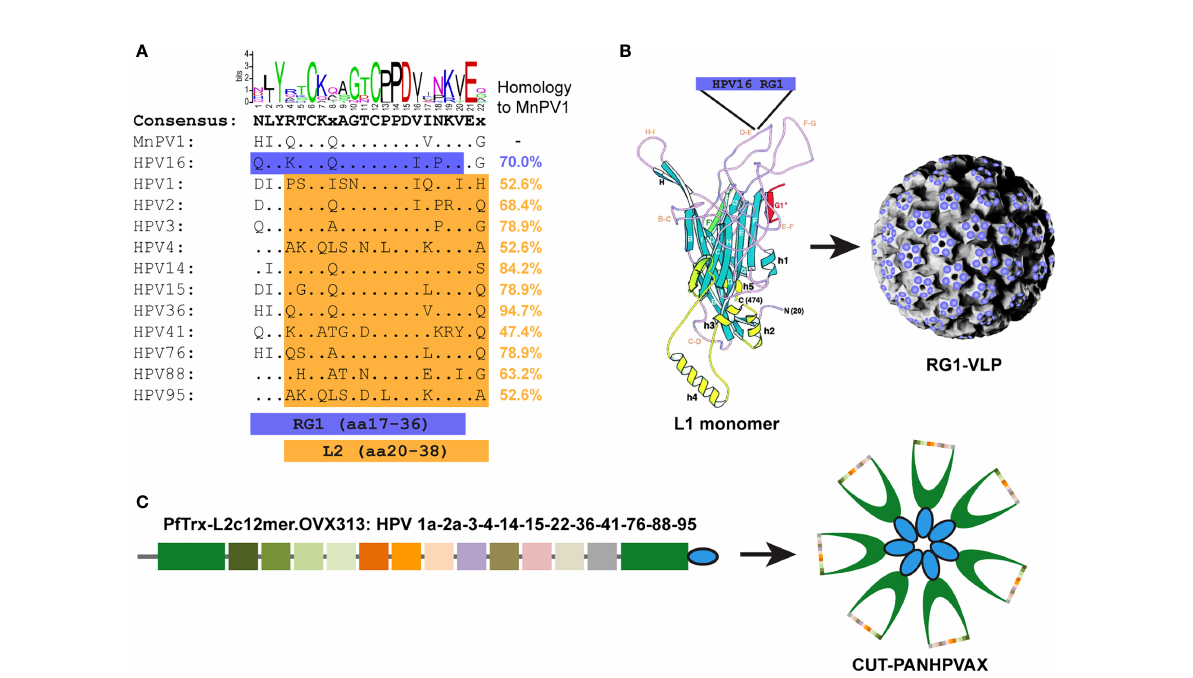
FIGURE 1 L2-based vaccines used in the study. (A) Alignment of L2 amino acid (aa) sequences of MnPV and HPV types either used in RG1-VLPs (HPV16 L2 aa17-36, referred to as ‘ RG1 ’ epitope, blue) or CUT-PANHPVAX (L2 aa20-38, orange of indicated HPV types) vaccine. Sequence identities in comparison to MnPV L2 are expressed as percentage. The logos graphically depict the consensus sequence. (B) The RG1 epitope of HPV16 L2 is inserted into the DE surface loop of the HPV16 L1 monomer, creating a chimeric fusion protein. After self-assembly into complete VLPs, the RG1 epitope is exposed 360 times [modi fi ed from (30)]. (C) The CUT-PANHPVAX is a fusion protein consisting of L2 peptides aa20-38 derived from the cutaneous HPV types 1a, 2a, 3, 4, 14, 15, 22, 36, 41, 76, 88 and 95, respectively, inserted into the thioredoxin scaffold (PfTrx, shown in green) derived from the thermophile archaea Pyrococcus furiosus . The OVX313 domains (shown in blue) assemble to heat-stable heptamers, leading to a seven-fold presentation of the respective PfTrx-L2 in the PfTrx-L2-c12merOVX313 fusion protein (modi fi ed from Mariz et al., 2022, in